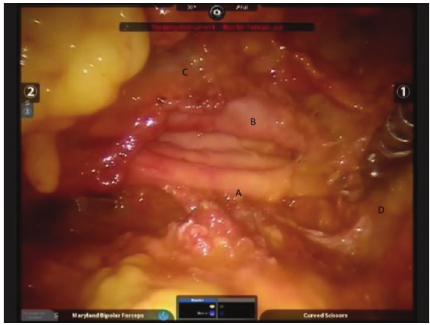
Figure 4: The picture showing the anatomical exposure of the lower part of the brachial plexus. A-lower truncal level, B-subclavian artery, C-subclavian vein, and D-fist